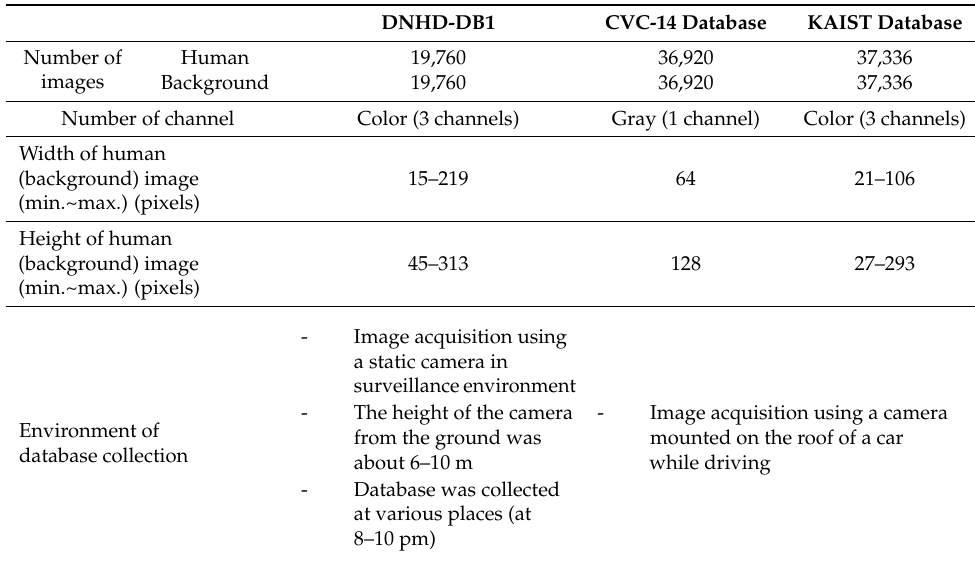
Table 3. Databases used in this